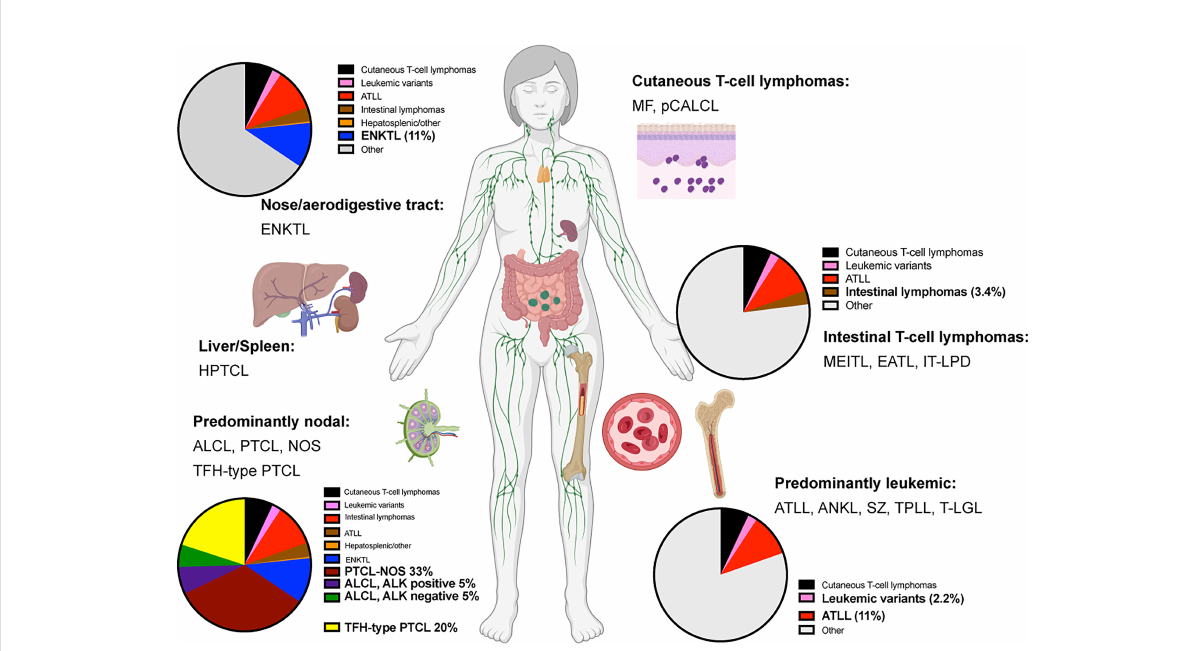
FIGURE 1 Predominant anatomical presentation and relative frequency of mature T-cell lymphomas. Abbreviations: Extranodal T/NK-cell lymphoma, nasal type (ENKTL); Hepatosplenic T-cell lymphoma (HPTCL); Anaplastic large cell lymphoma (ALCL); Peripheral T-cell lymphoma, non-otherwise speci fi ed (PTCL, NOS); T-follicular helper type peripheral T-cell lymphoma (TFH-PTCL); Mycosis Fungoides (MF); Primary cutaneous anaplastic large cell lymphoma (pCALCL); Monomorphic epitheliotropic intestinal T-cell lymphoma (MEITL), Enteropathy-associated T-cell lymphoma (EATL); Indolent T-cell lymphoproliferative disease of the gastrointestinal tract (IT-LPD); Adult T-cell leukemia/lymphoma (ATLL); Aggressive NK- cell leukemia (ANKL); Sèzary Syndrome (SZ); T-cell prolymphocytic lymphoma (T-PLL); T-cell large granular lymphoma